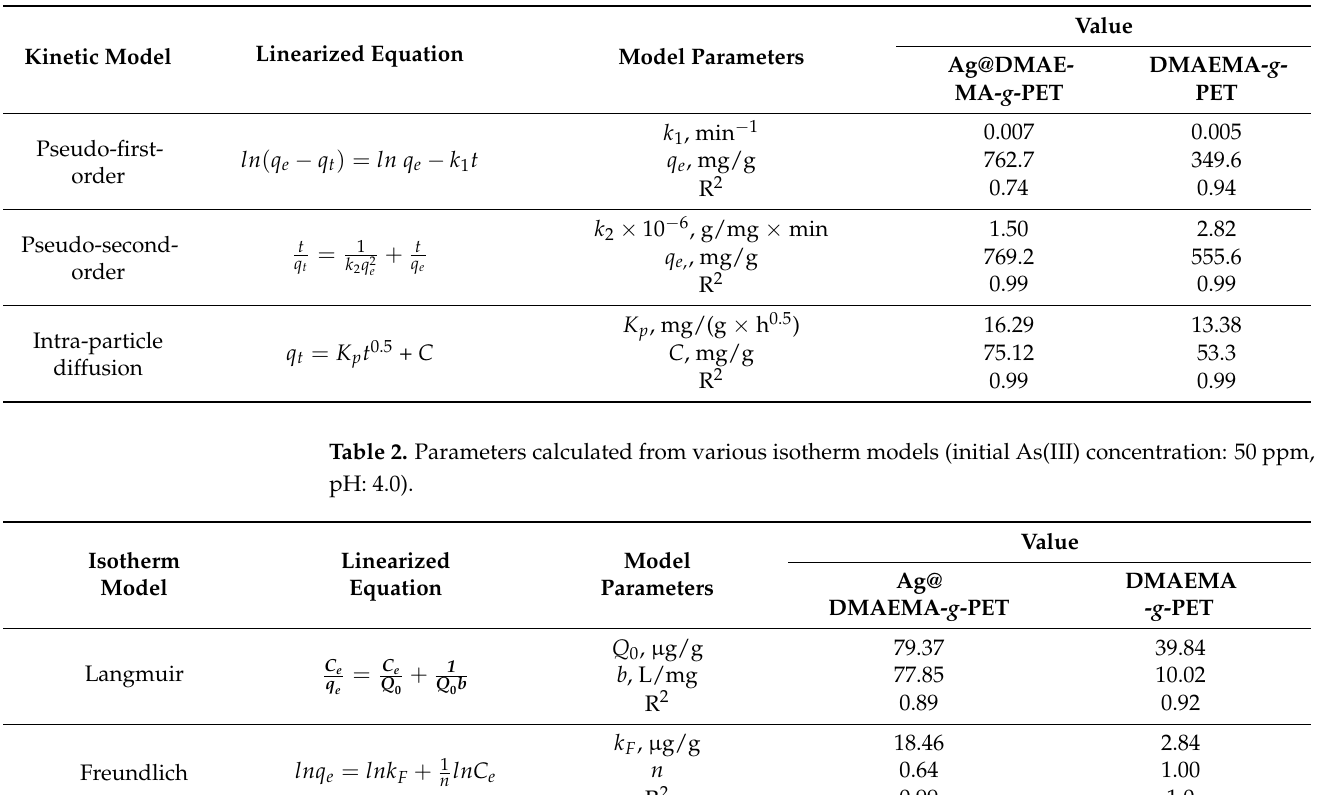
Table 1. Parameters calculated from various kinetic models (initial As(III) concentration: 50 ppm, pH: 4.0).